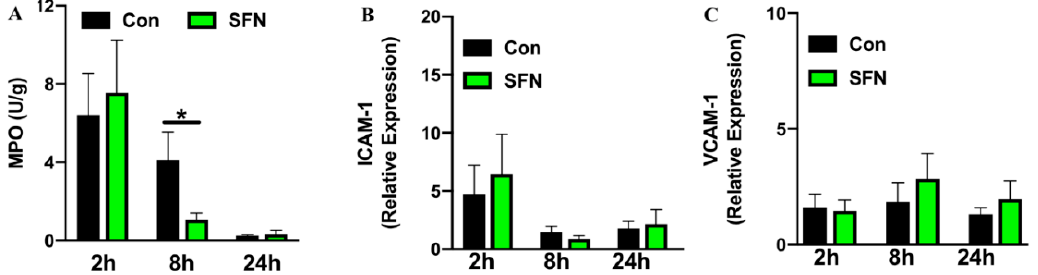
Figure 3. Intestinal neutrophil infiltration measured by MPO activity ( A ) and expression of ICAM-1 ( B ) and VCAM-1 ( C ) determined by qPCR and presented as relative gene expression. All assays were conducted in tissue samples (ileum) of control (CON) and SFN-treated (SFN) animals with 2 h, 8 h and 24 h of reperfusion. All data are presented as mean values ± SEM, n = 8–10 animals per group. Significance is indicated by the following symbol: * = p < 0.05 versus Con.